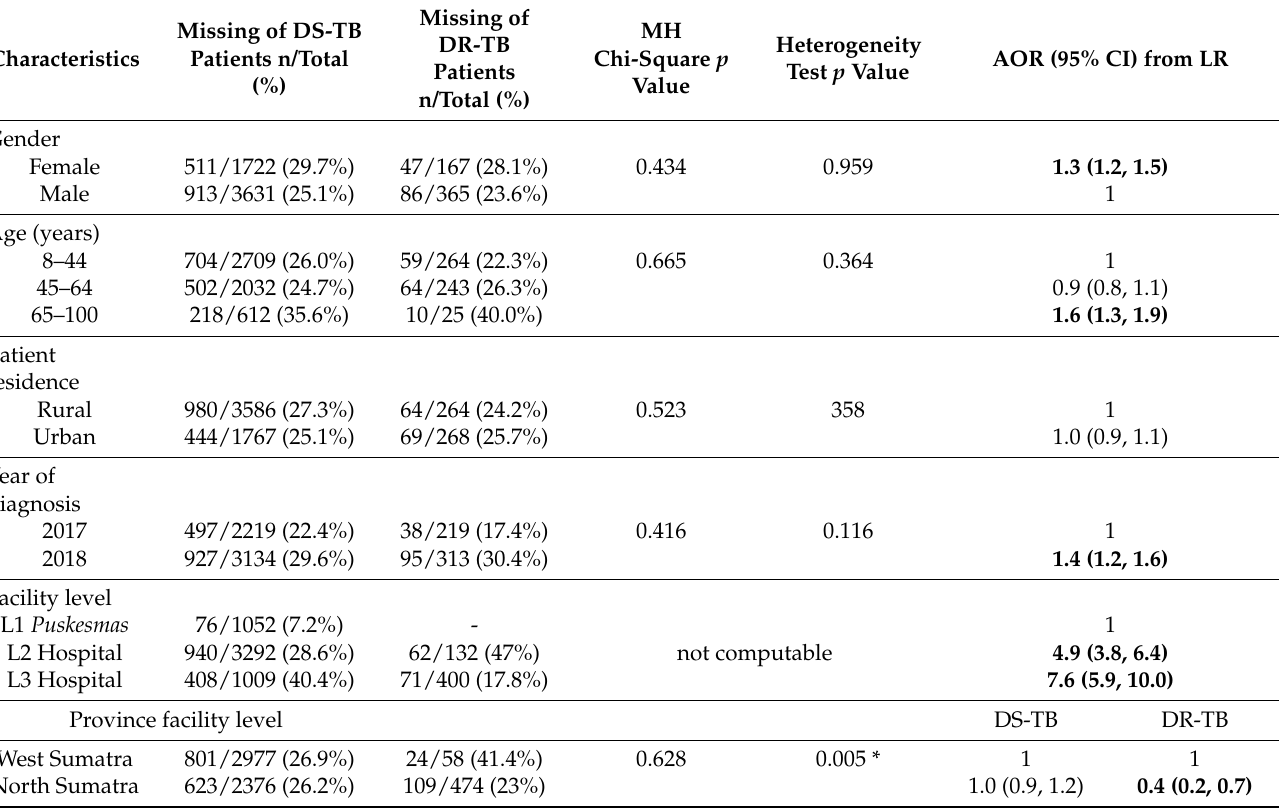
Table 4. Fractions of type of TB patients that were missing in notification database, stratified analysis, and factors associated with missing cases in the provinces of North Sumatra and West